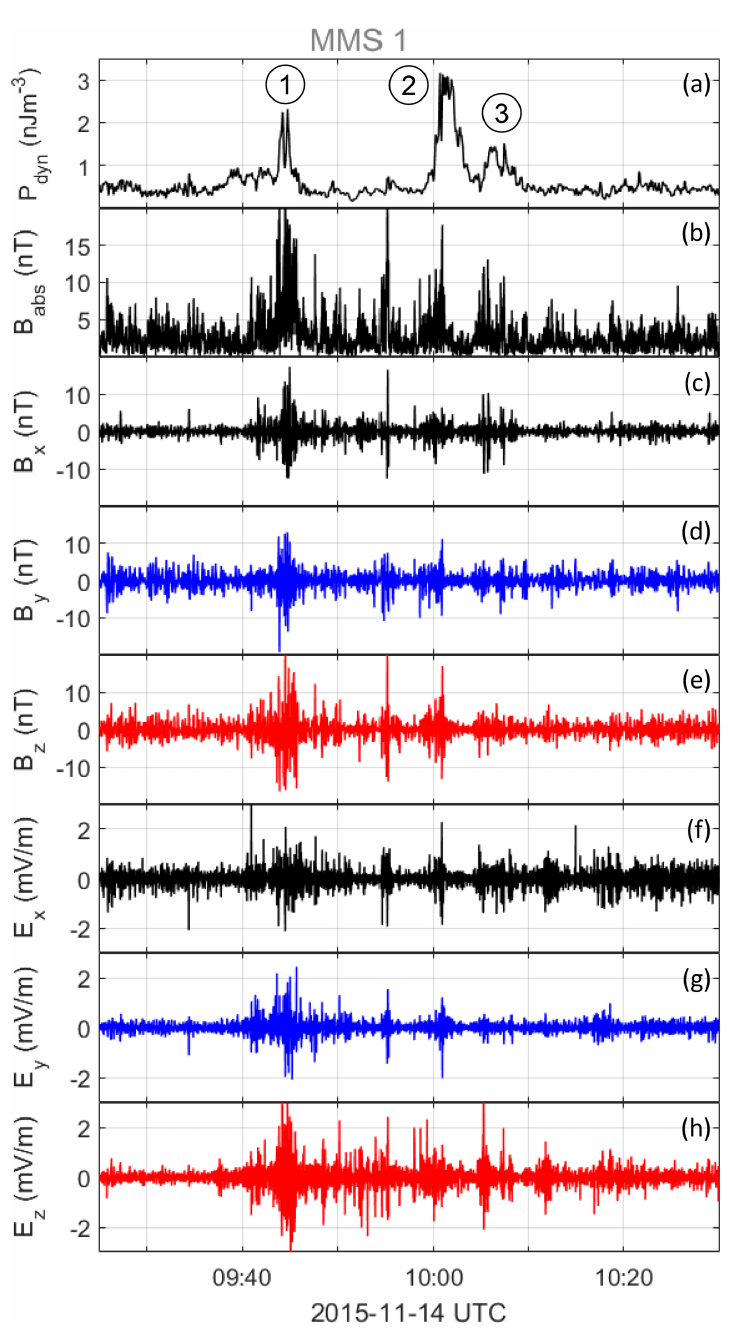
Figure 7. Low-frequency wave activity. From top to bottom: dynamic pressure, absolute value of magnetic field, and magnetic and electric field components. For all panels (except the top one) the DC component has been removed by subtracting a 25s running